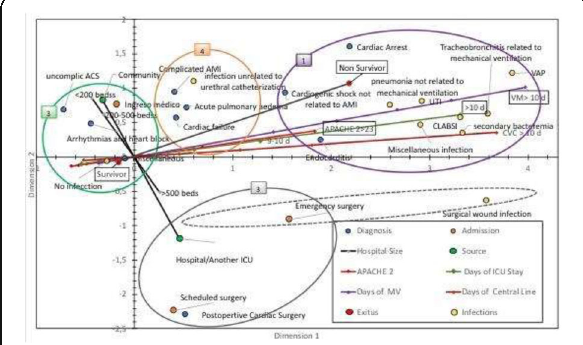
Fig. 1 (abstract 0071). CAPTCA Model 1:Variables at admission , diagnosis,infections,lenght of devices and